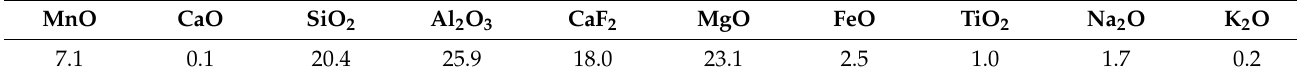
Table 2. Flux composition